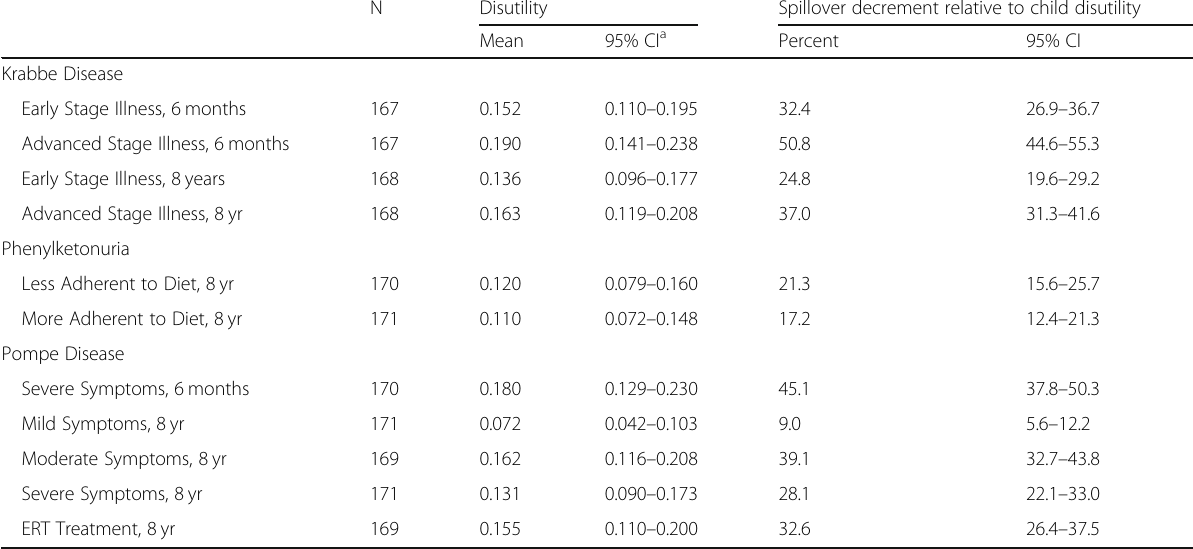
Table 3 Disutility estimates of parental spillover quantifying health-related quality of life losses due to childhood